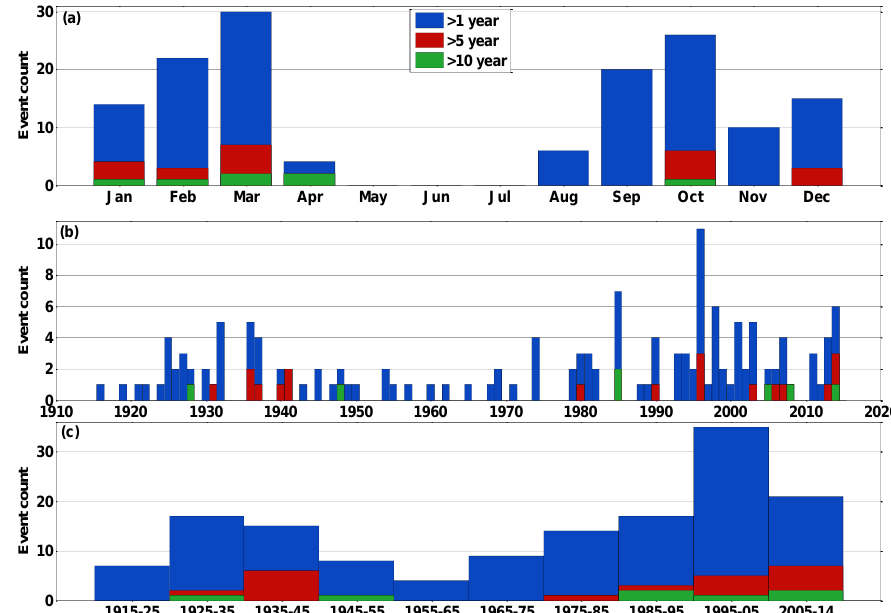
Figure 4. (a) Months in which extreme sea level events fall at Newlyn (for the entire 1915–2014 data set, for single tidal cycle events Figure 4 (a). Months in which extreme sea level events fall at Newlyn (for the entire 1915-2014 dataset, for single tidal cycle events with 2 with return periods classified by the 1.81mmyear − 1 SLR offset). (b) Counts of extreme sea level events (using the offset return periods) in return periods classified by the 1.81 mm/year SLR offset). (b). Counts of extreme sea level events (using the offset return periods) in July-July 3 July–July years; (c) counts of extreme sea level events grouped by years; (c) counts of extreme sea level events grouped by decades. 4